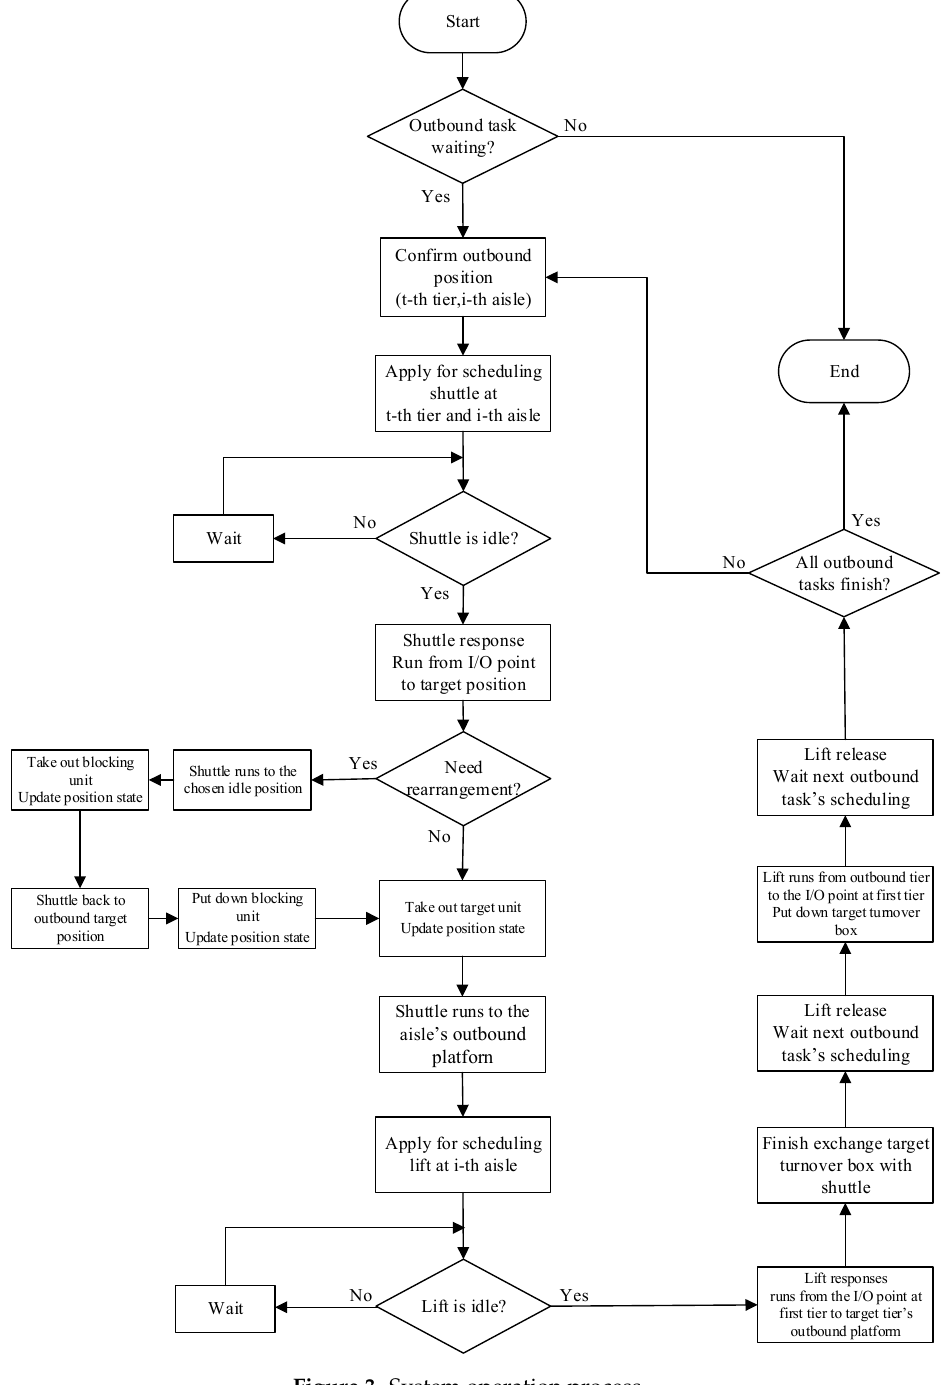
Figure 3. System operation process.